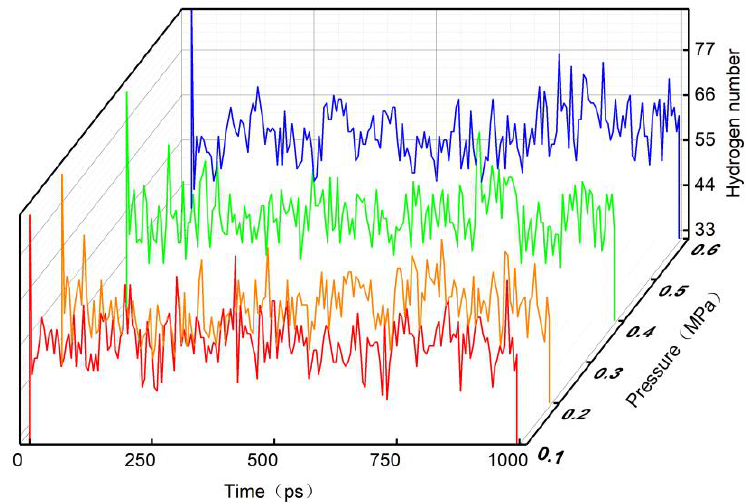
Figure 7. Number of hydrogen bonds between amorphous cellulose region – water at 0.1, 0.2, 0.4, and 0.6 MPa (red, orange, green, blue).